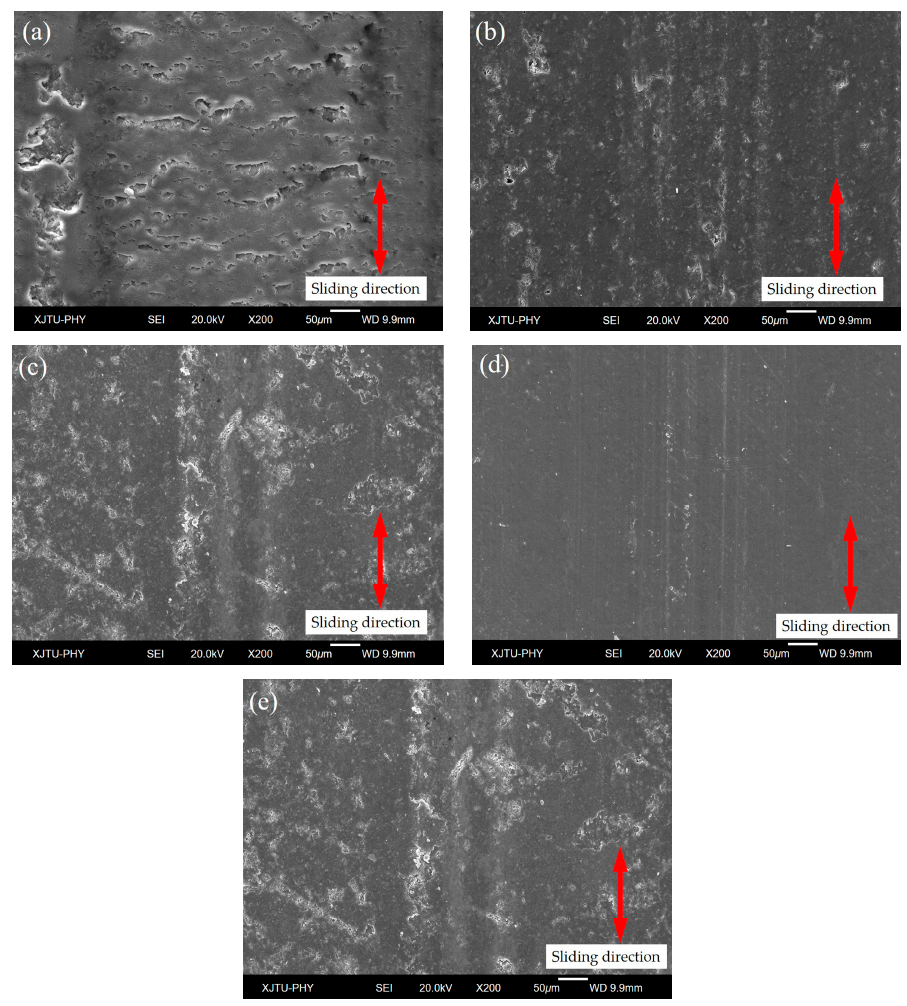
Figure 8. SEM images of worn surfaces of epoxy coating with the graphene content of ( a ) 0.0 wt %, ( b ) 1.0 wt %, ( c ) 2.0 wt %, ( d ) 3.0 wt %, and ( e ) 4.0 wt %, respectively, at room temperature.